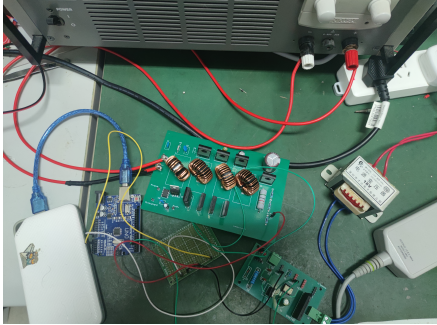
Figure 12. Experimental environment.